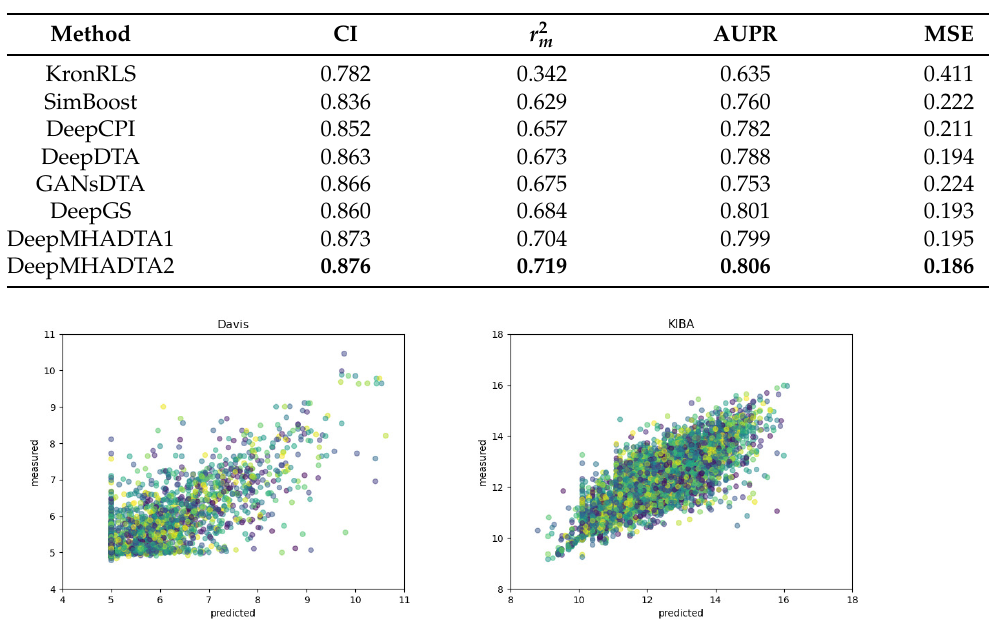
Table 3. Comparison of our method with six competitve methods on KIBA dataset.